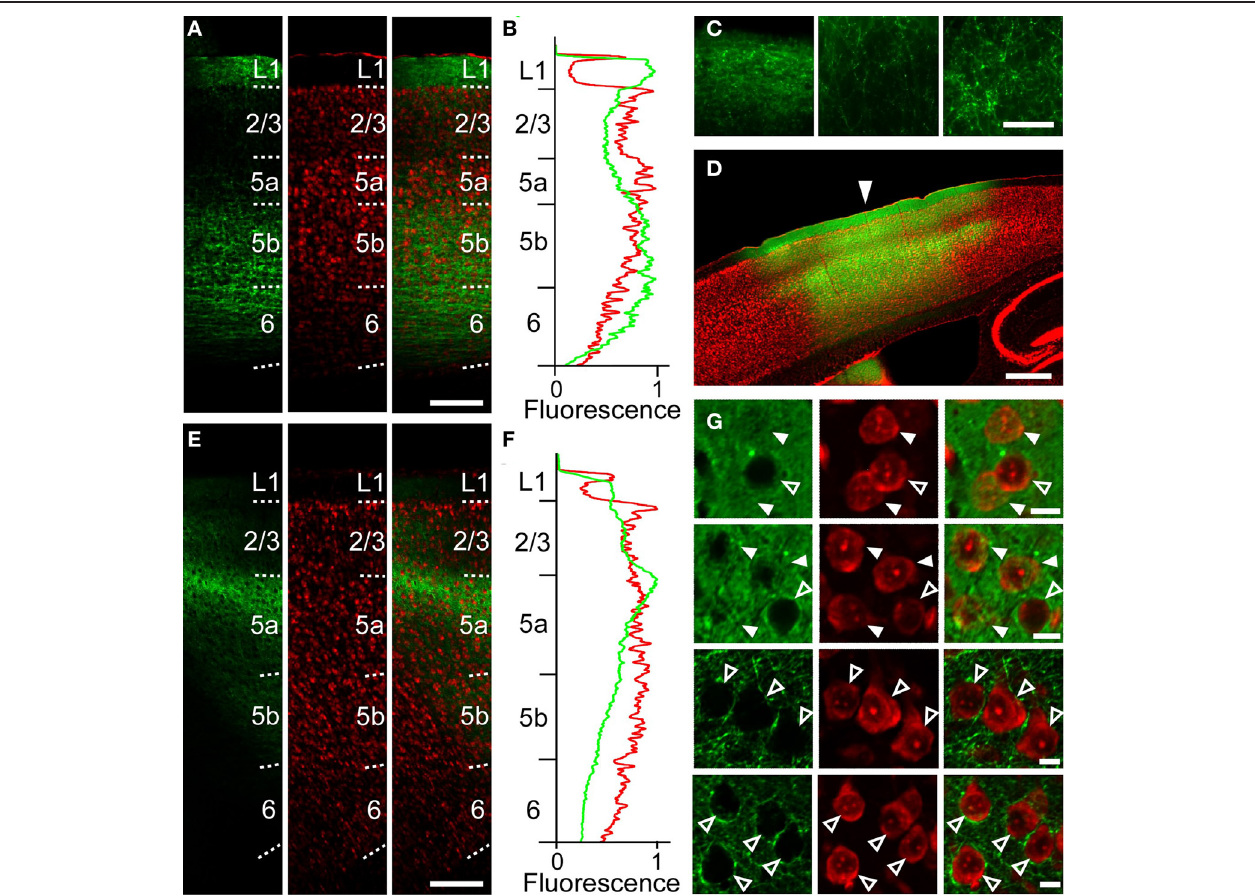
FIGURE 5 | Anatomical tracings of axonal fibers between the RFA and the CFA. (A) Anti-GFP immunofluorescence (left), Nissl staining (middle), and the overlay (right) in the CFA in a sagittal section after AAV-ChR2-EYFP injection into the RFA in Figure 2B . Scale bar, 200 µ m. (B) Profiles of anti-GFP immunofluorescence (green) and Nissl staining (red) in (A) as a function of laminar depth. Fluorescence was background subtracted and normalized. (C) Higher magnification of GFP-immunofluorescence in (A) . Left, L1. Middle, L2/3. Right, L5b. Scale bar, 50 µ m. (D) Overlay of EYFP fluorescence (green), Nissl staining (red) in a sagittal section of a mouse in which AAV-ChR2-EYFP was injected into the CFA. Arrowhead indicates 0mm